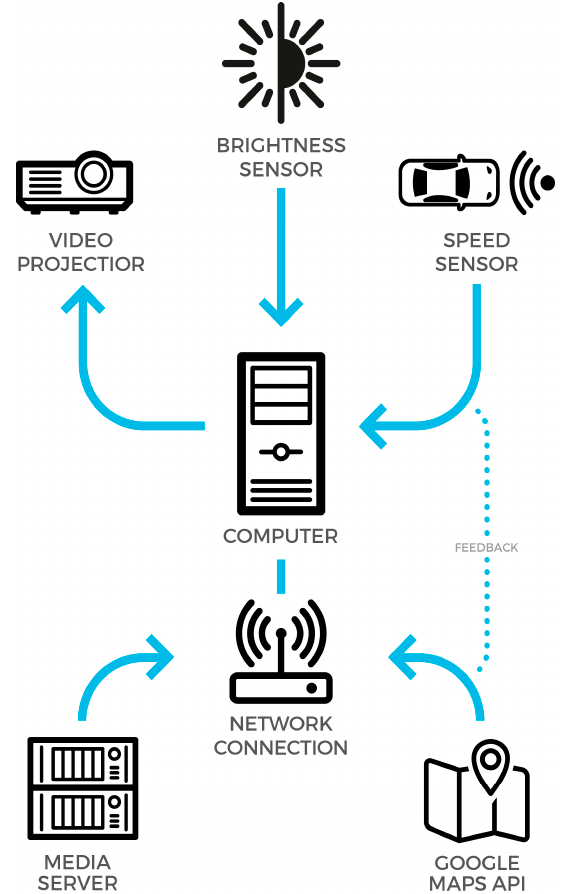
Figure 8. System management scheme (image by Rosario Di